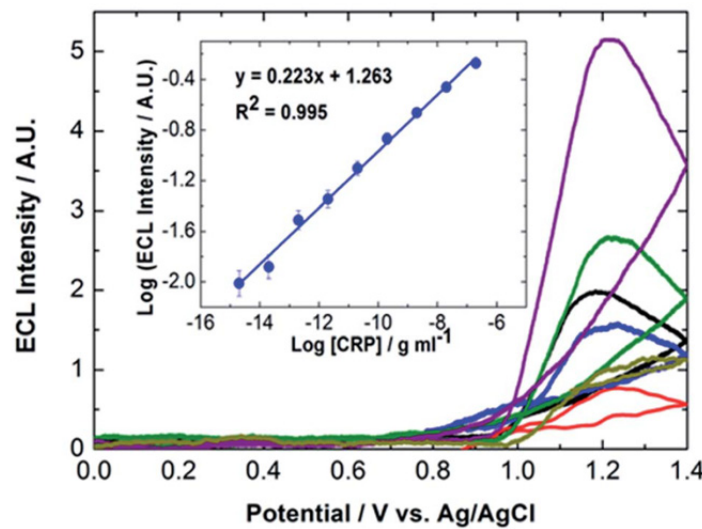
Figure 15. Dependence of the ECL emission intensity on the CRP concentration. From top to bottom at +1.2 V, the concentrations of CRP range from 600 ng mL − 1 to 5 fg mL − 1 . Not all ECL responses are shown. The inset shows dependence of the logarithm of the maximum ECL intensity on log[CRP]. The error bars are comparable to, or smaller than, the size of the symbols. Reproduced with permission from [90].